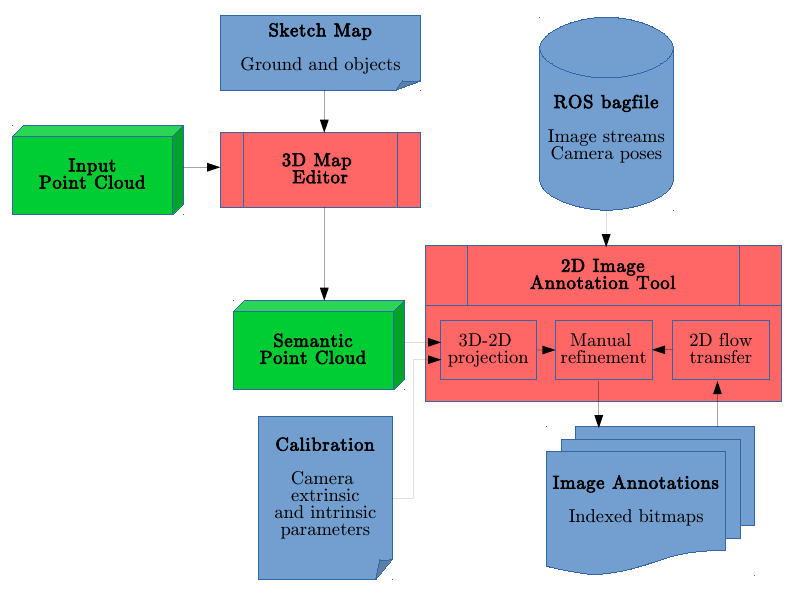
Figure 3. Semantic annotation workflow. In the first stage, the acquired point cloud representing the scene geometry is enriched with semantic information using the 3D Map Editor (upper red